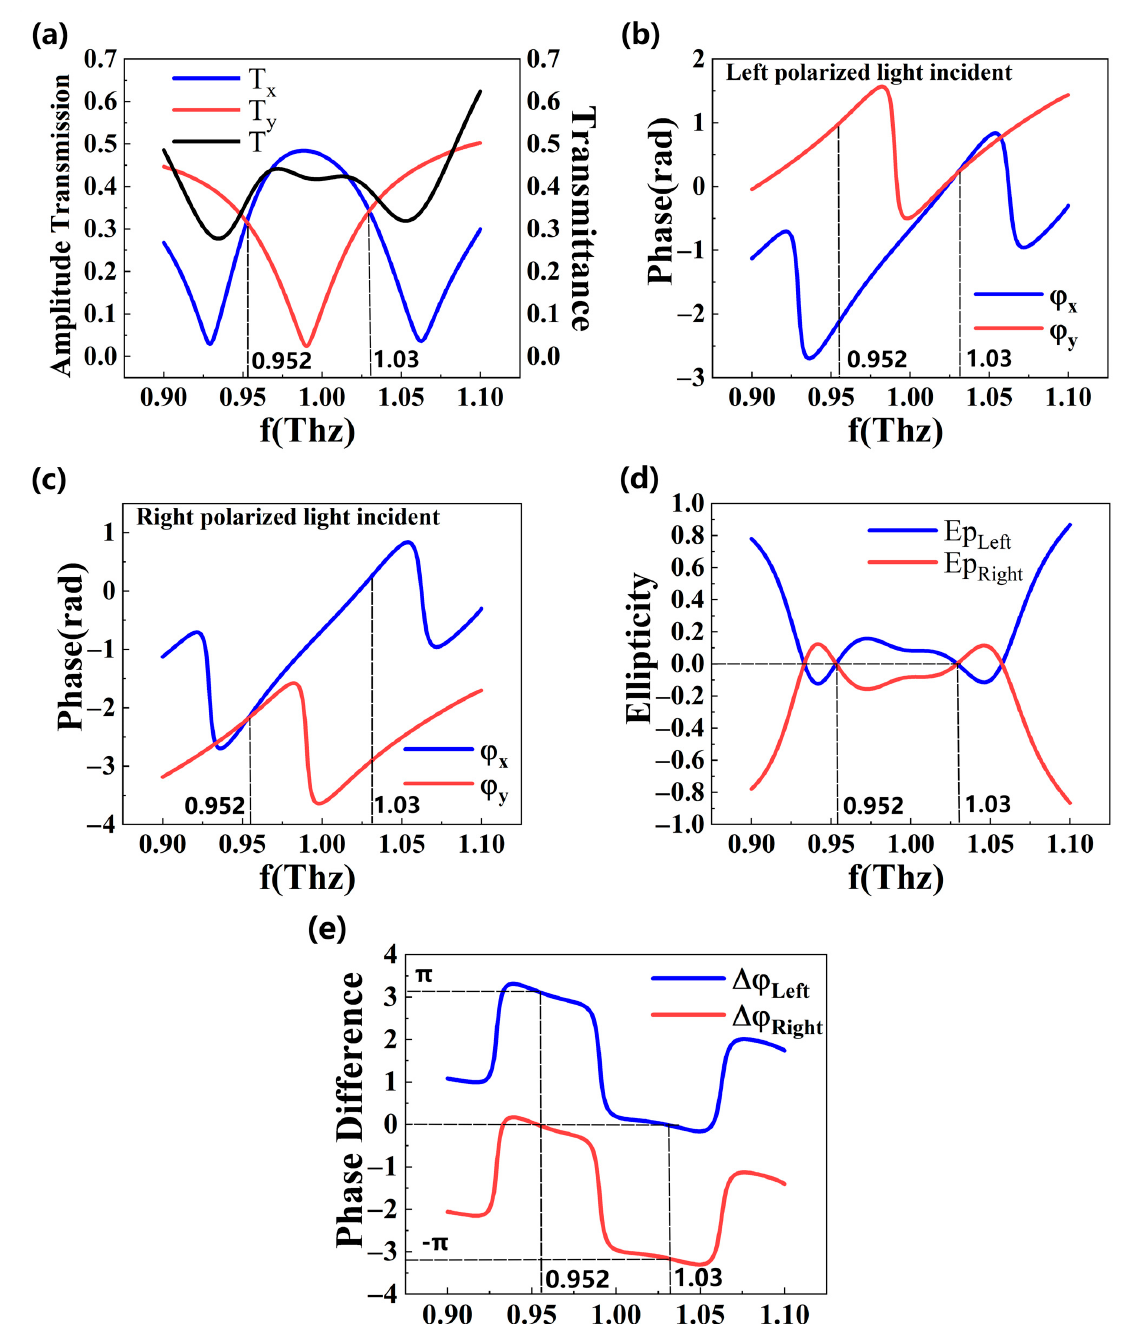
Figure 7. Correspondence between the performance parameters of the quarter-wave plate and the frequency. ( a ) Amplitude and transmittance of the x and y electric field components. ( b ) Phase delay of the x and y electric field components (left polarized light incident). ( c ) Phase delay of the x and y electric field components (right polarized light incident). ( d ) The ellipticity of the outgoing light. ( e ) The phase difference between the x and y electric field components of the outgoing light.